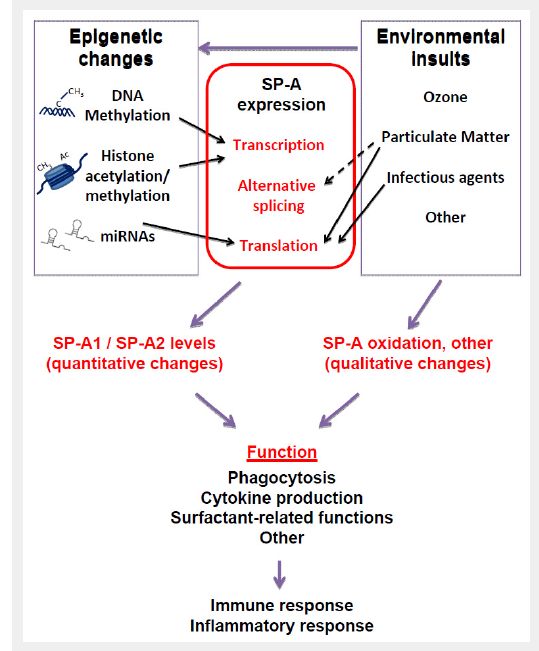
Epigenetics and the environment on SP-A expression and function. The effects of different environmental pollutants on epigenetics have been extensively studied and reported [1–6]. Environmental insults hold the potential to affect SP-A both qualitatively and quantitatively. Epigenetic mechanisms affect SP-A expression by altering transcription including methylation of CpG sites in the SP-A promoters [24, 74], and modifications of histones located in the chromatin of SP-A regulatory sequences [75, 76]), as well as translation efficiency (miRNA-mediated repression [77]). As a result, the relative content of SP-A1 and SP-A2 is affected, resulting in altered immune and inflammatory responses. SP-A is also affected by environmental insults. Oxidation of SP-A is increased after ozone exposure [43, 47], with subsequent effects on innate immunity and inflammatory processes and surfactant-related functions [26, 43, 85]. An effect of particulate matter on alternative splicing of SP-A transcripts (our unpublished data), and on translation may also occur [25]. Particulate matter and infection with RSV affect SP-A levels by altering translation efficiency [25, 83]. Arrows indicate published data; broken arrow indicates preliminary/ unpublished